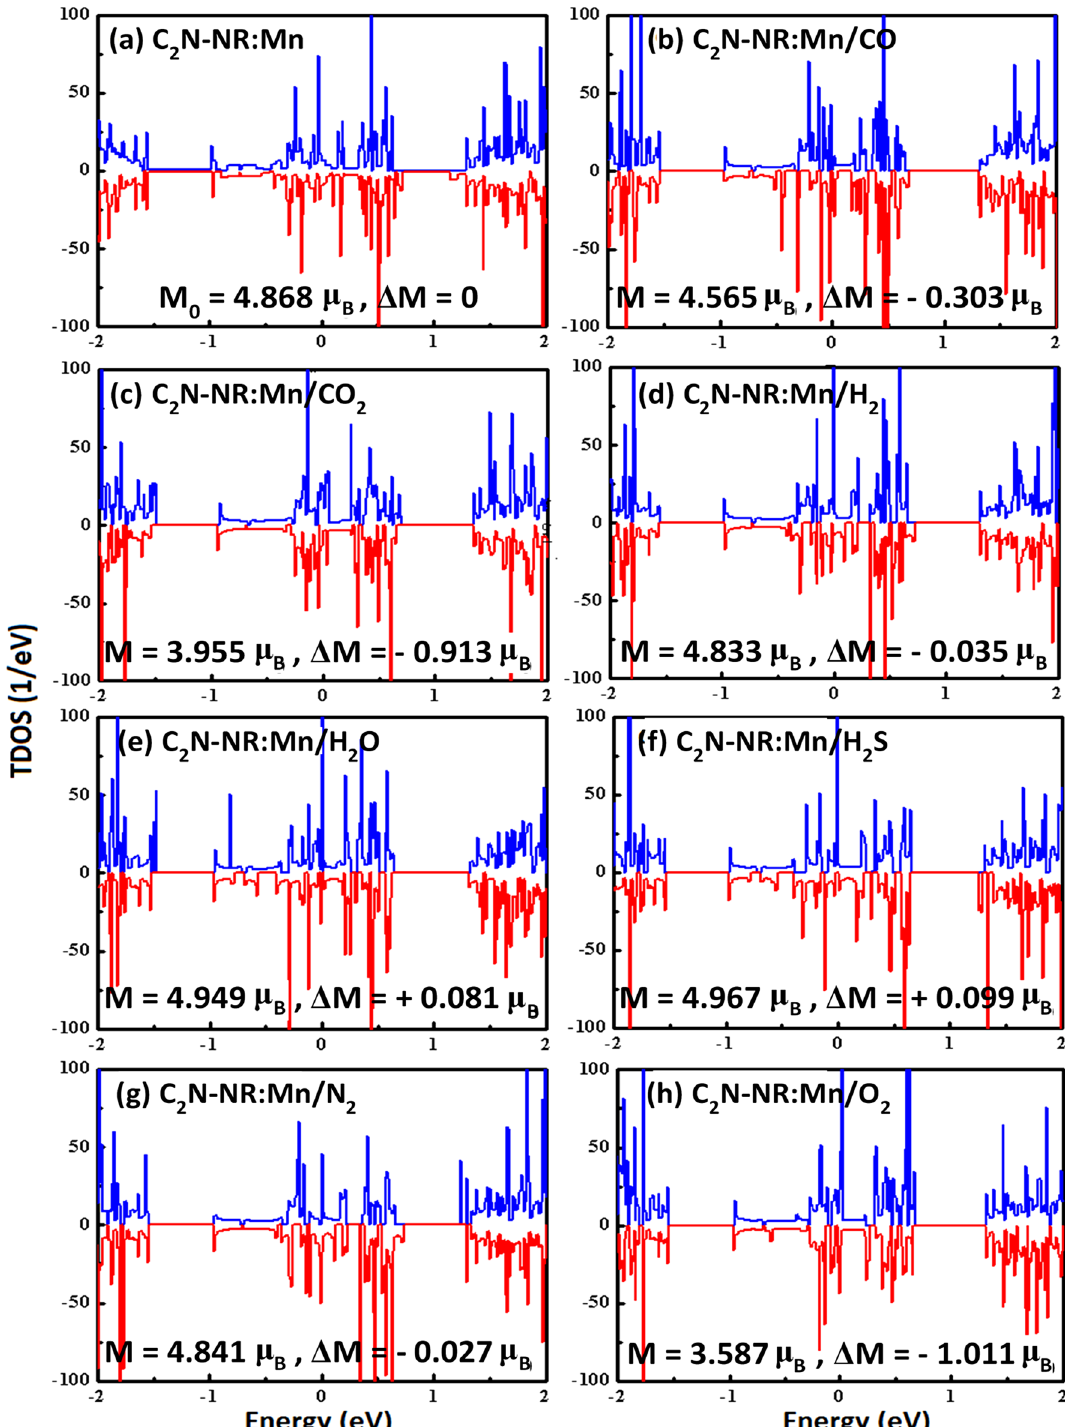
Figure. 3. Spin-polarized Total Density of States (TDOS) for C 2 N-NR:1Mn with various gas (PDOS) and orbital density of states (ODOS). Figure 4 displays the results of spin-polarized PDOS on same sys- tems presented in previous figure. In each panel, spin-up and spin-down contributions to PDOS are presented on the positive and negative sides, respectively. Moreover, the PDOS are clearly shown to have many peaks which correspond to Van-Hove singularities as characteristics of DOS of 1D systems. It is worth eliciting that in all panels hydrogen contributions should be expected as the hydrogen atoms were used to saturate the dangling bonds at the NR-edges. It is further clearly noticed the existence of asymmetry between spin-up and spin-down